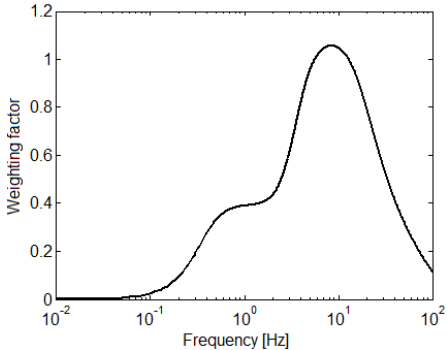
Figure 3. The frequency weighting function of the filter W ab .